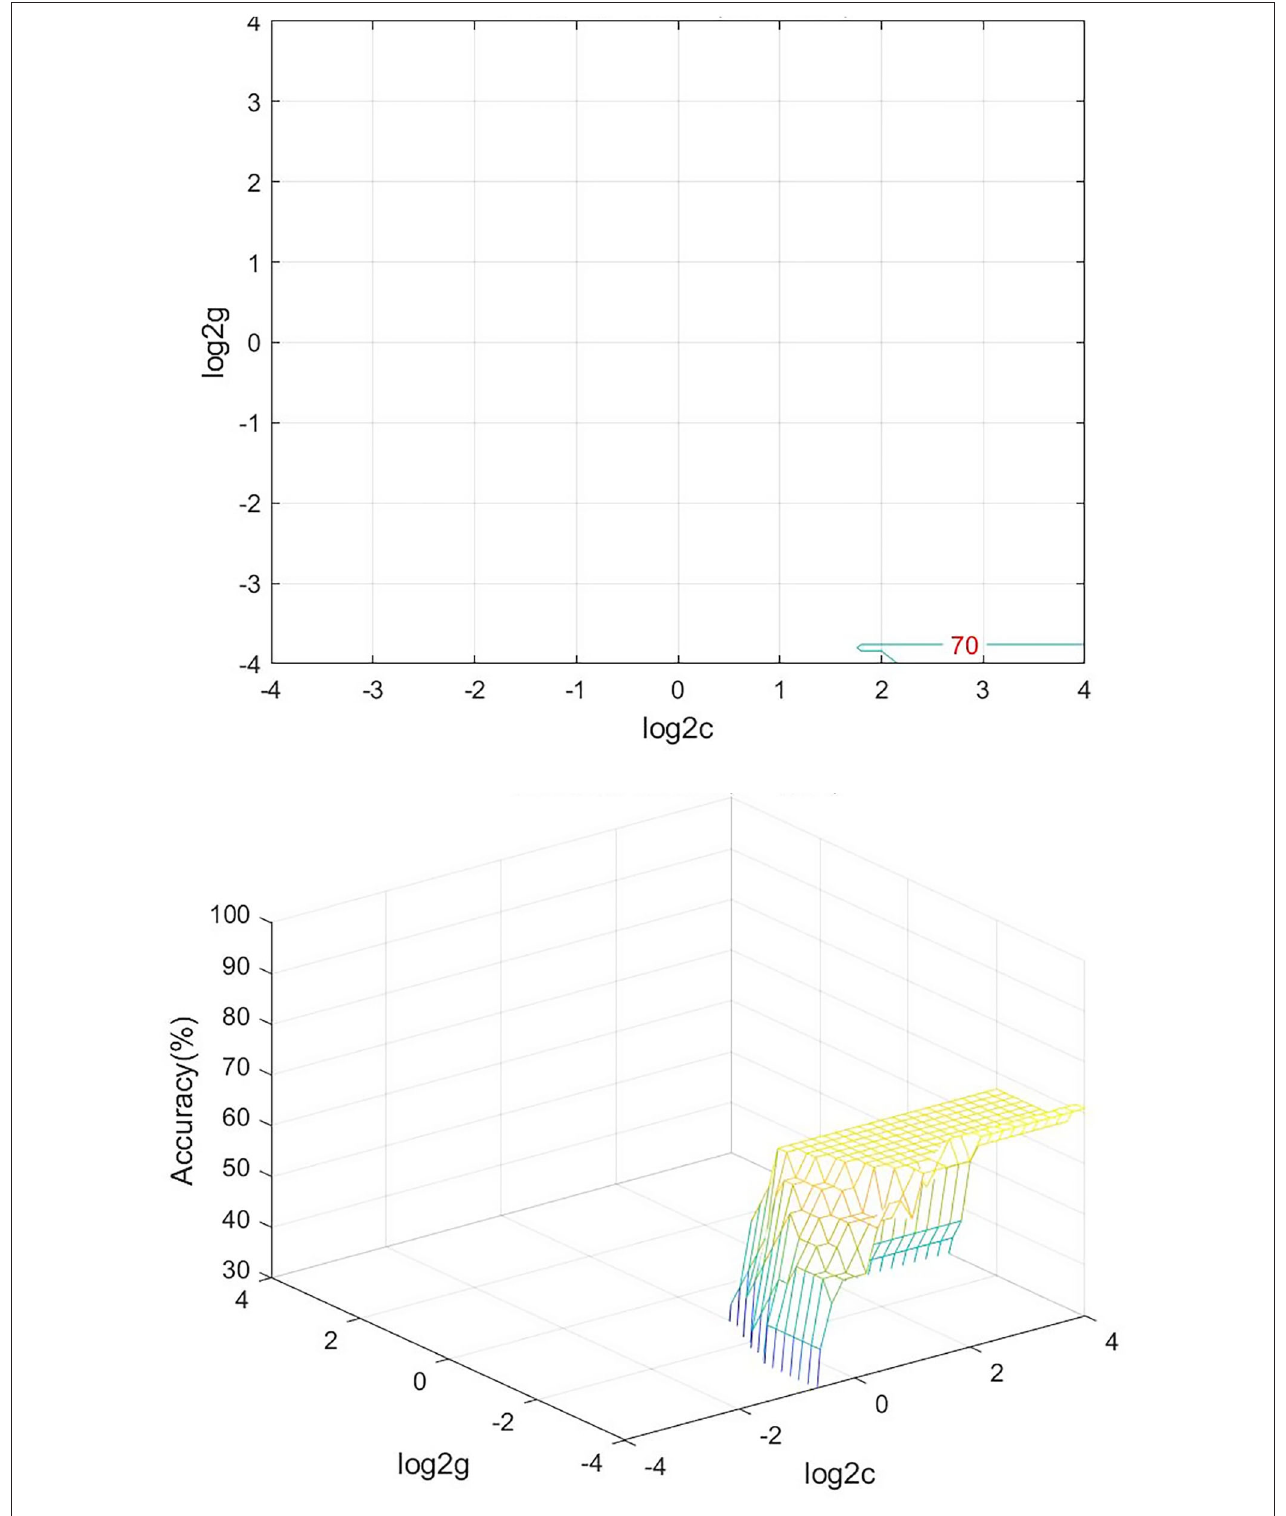
FIGURE 3 | Visualization of SVM results for TA and HC. Left, Visualization of the classification map. Right, 3D view of classification accuracy with best parameters. SVM, support vector machine; TA, toothache; HC, healthy control.